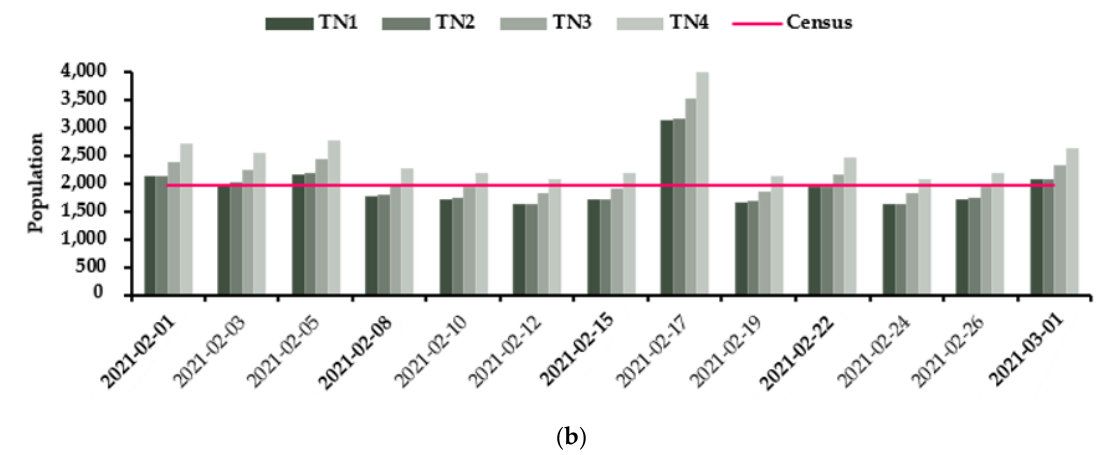
Figure 2. Overview of census and estimated population size at RAN WWTP on the identified sampling dates, wherein population size is estimated using four TP excretion rates ( a ) and four TN excretion rates ( b ) (note: dates in bold indicate 72 h (weekend) samples).